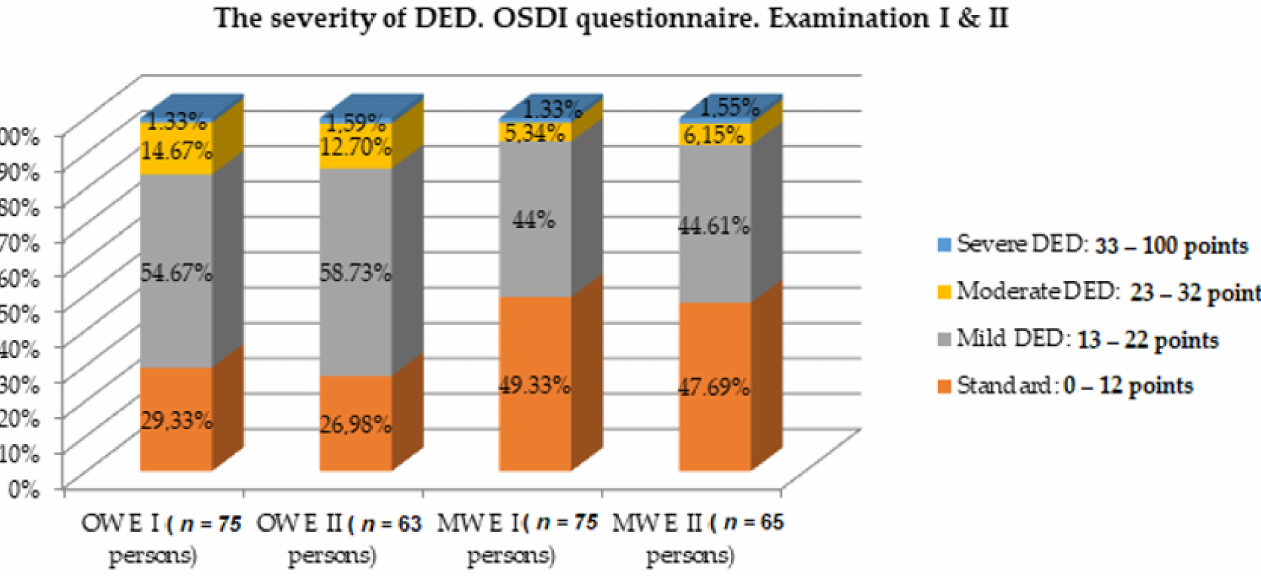
Figure 7. Comparison of the results of the OSDI questionnaire in both groups at the beginning of the study and after 1